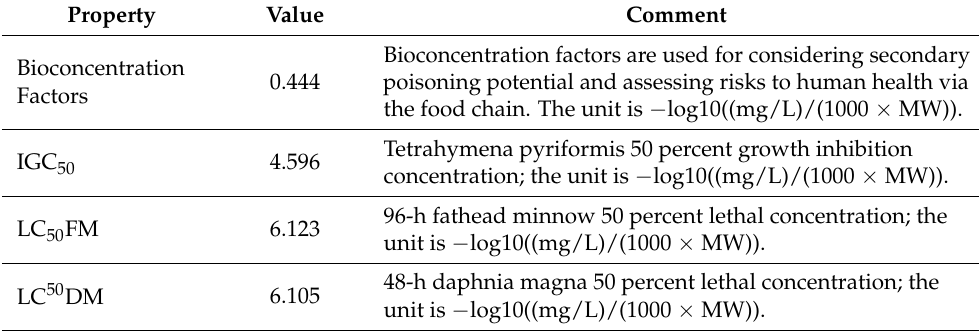
Table 13. The properties of the environmental toxicity of compound 1